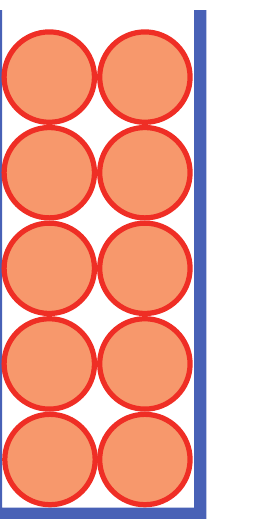
Figure 4: Schematic diagram of conductor placement in grooves for each layer.